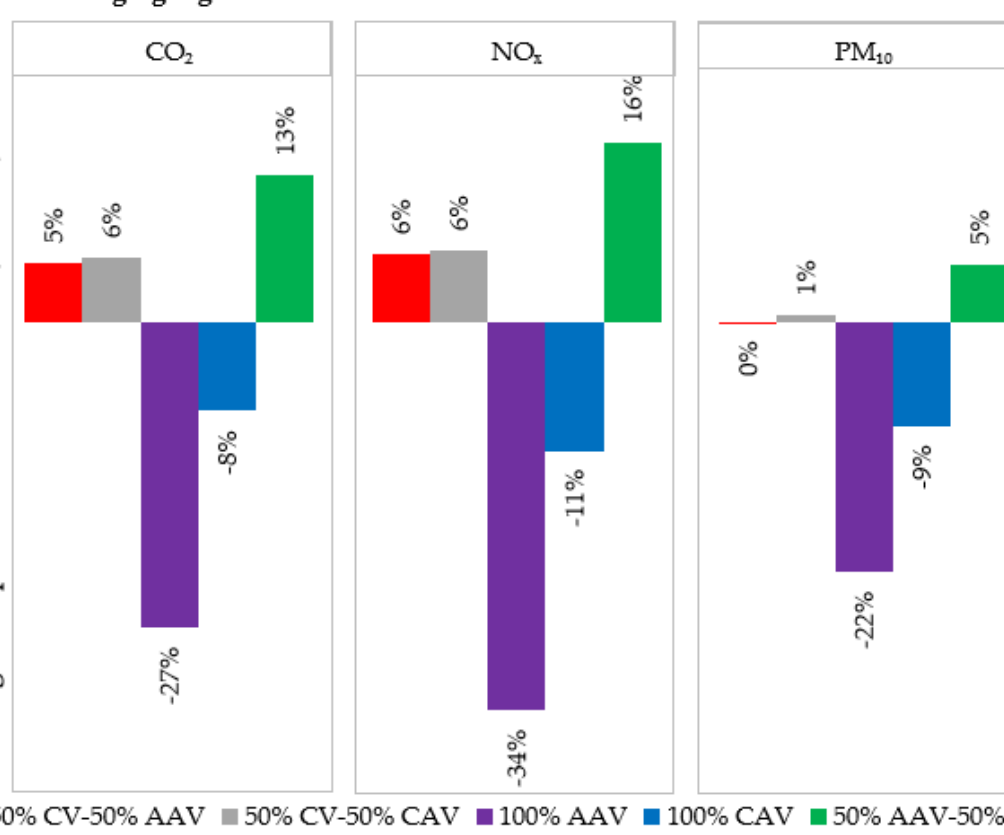
Figure 8. Simulation results of traffic emissions compared to the base scenario (100% CV): merging segment.